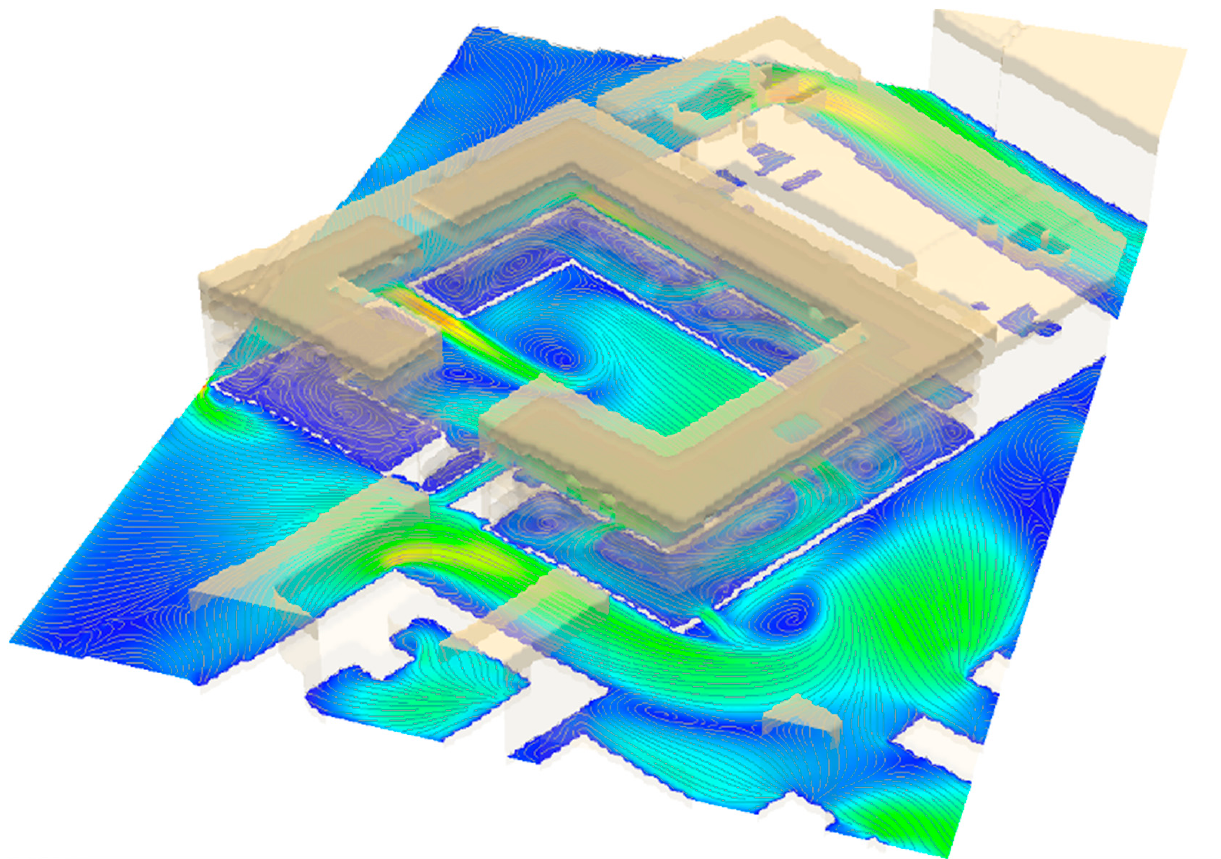
Figure 7. 3D view of the flow streamlines for the nested domain both in the vicinity of and inside the administration building. The wind speed ranges from 0 m/s in deep blue to 3.5 m/s in orange.